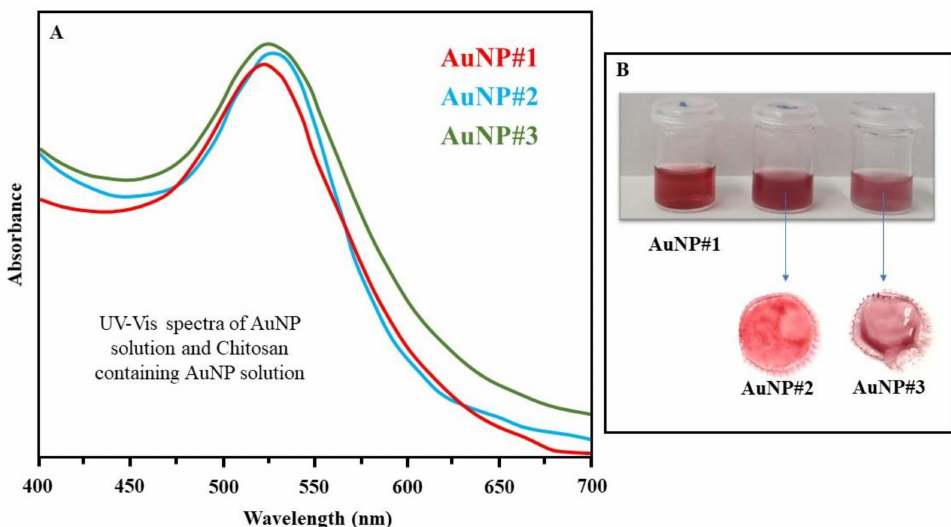
Figure 3. ( A ) UV-vis spectra of solutions AuNP#9, AuNP#10 and AuNP#11. ( B ) Image of solutions AuNP#9, AuNP#10, and AuNP#11 and drop-cast films formed from AuNP#9 and AuNP#11 mixed with tea tree